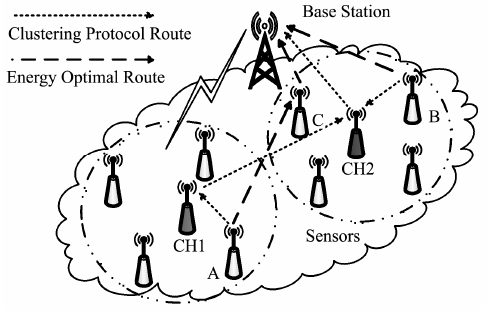
Figure 2. Route of clustering protocol in wireless sensor networks.